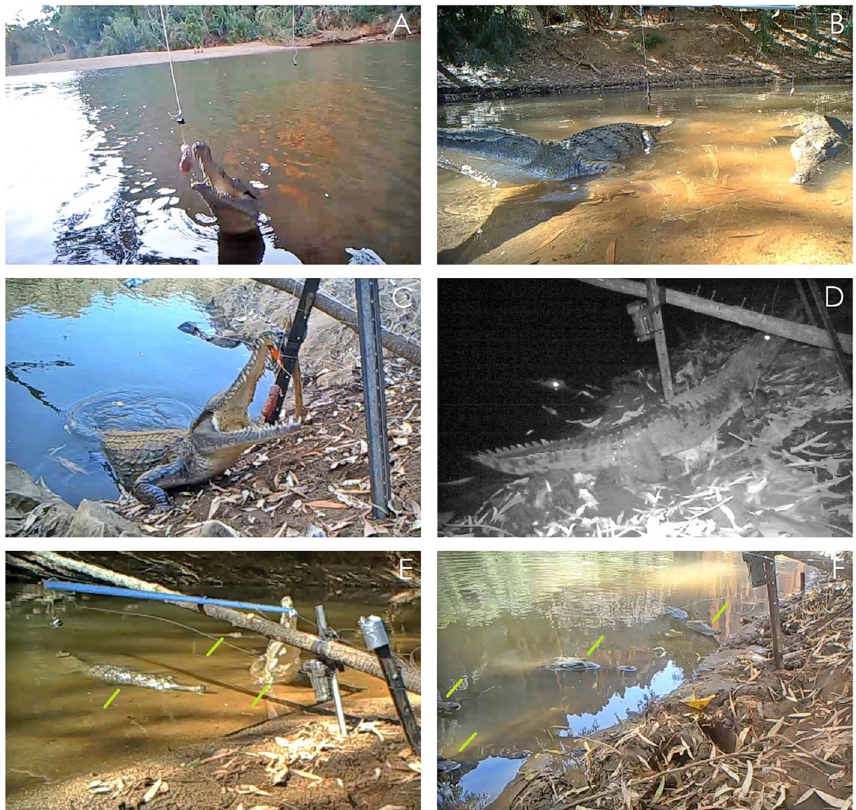
Figure 1. Photographs of freshwater crocodiles taking baits during baiting trials, from the water ( A , B ); as well as on land ( C , D ), and showing that sometimes multiple crocodiles visited the bait stations concurrently ( E , F ; green lines indicate individuals). Photographs taken from remote camera footage and by M.